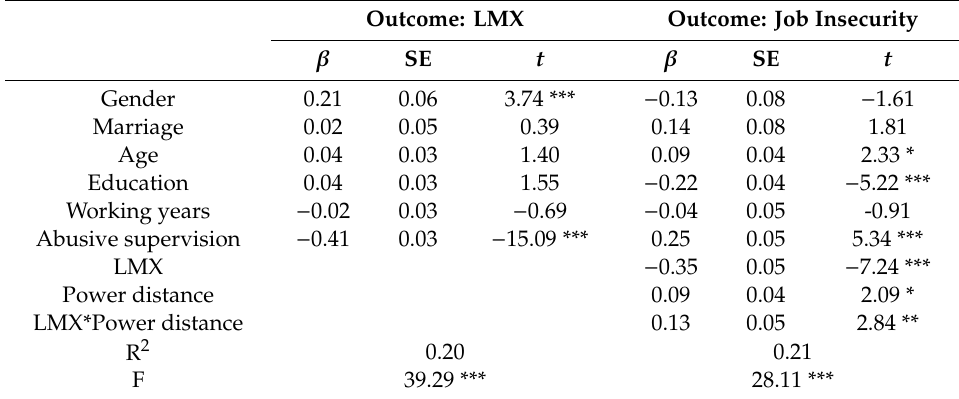
Table 3. Moderated mediating e ff ect.